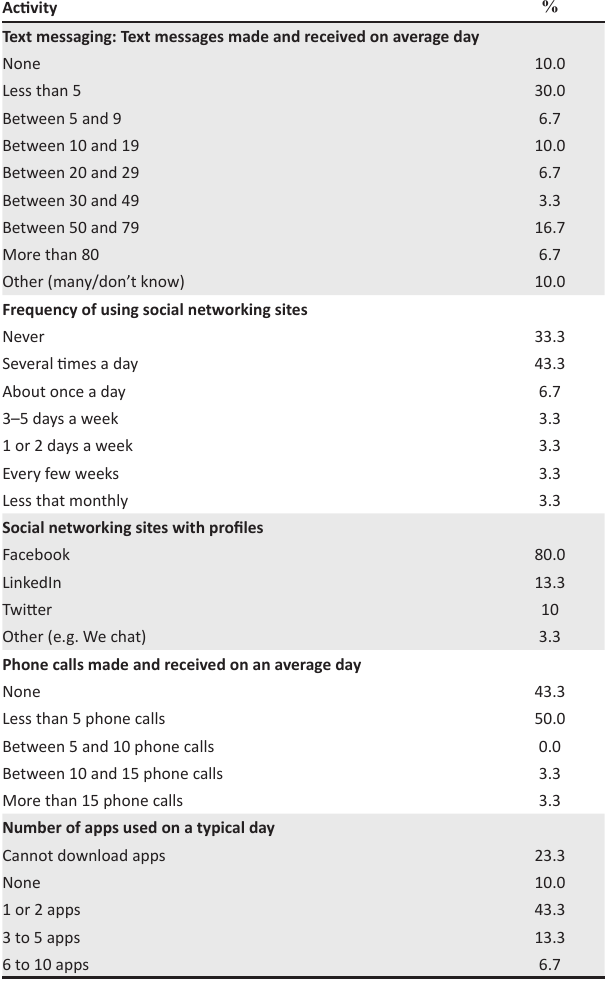
TABLE 7: Frequency of participants’ wireless activities: Text messaging, voice calling, social media and downloading apps ( N = 30). Activity %